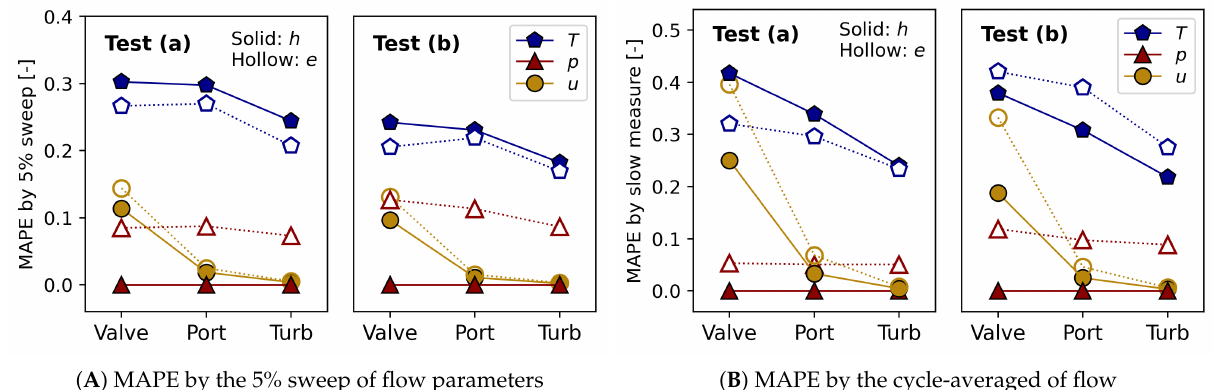
Figure 11. MAPE for the specific enthalpy and exergy at test points (a) and (b). The solid markers represent enthalpy, and the hollow markers represent exergy.